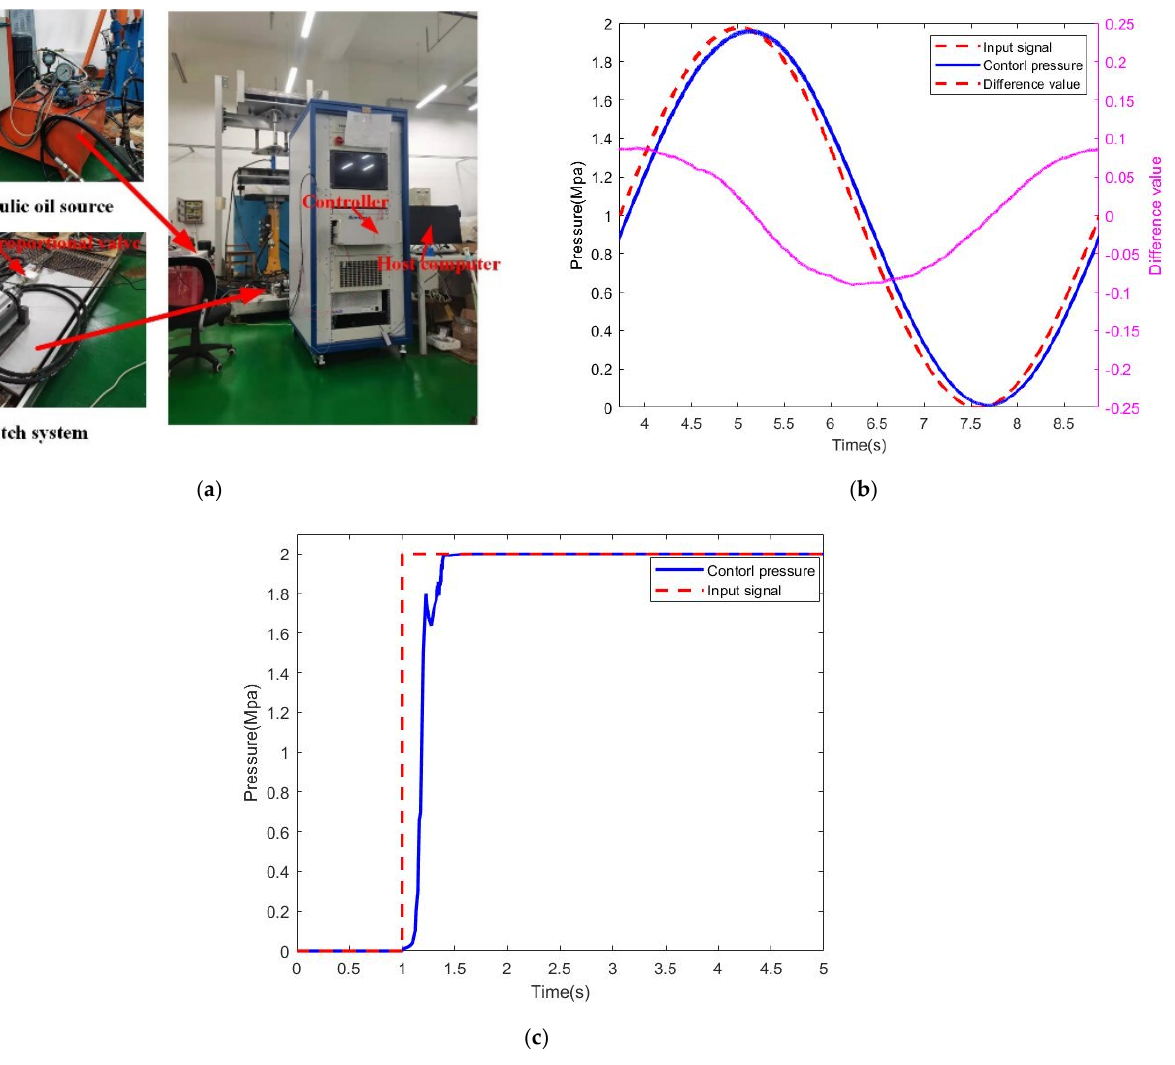
Figure 10. Results of clutch control test. ( a ) Clutch test bench; ( b ) Step signal control; ( c ) Sinusoidal signal control.